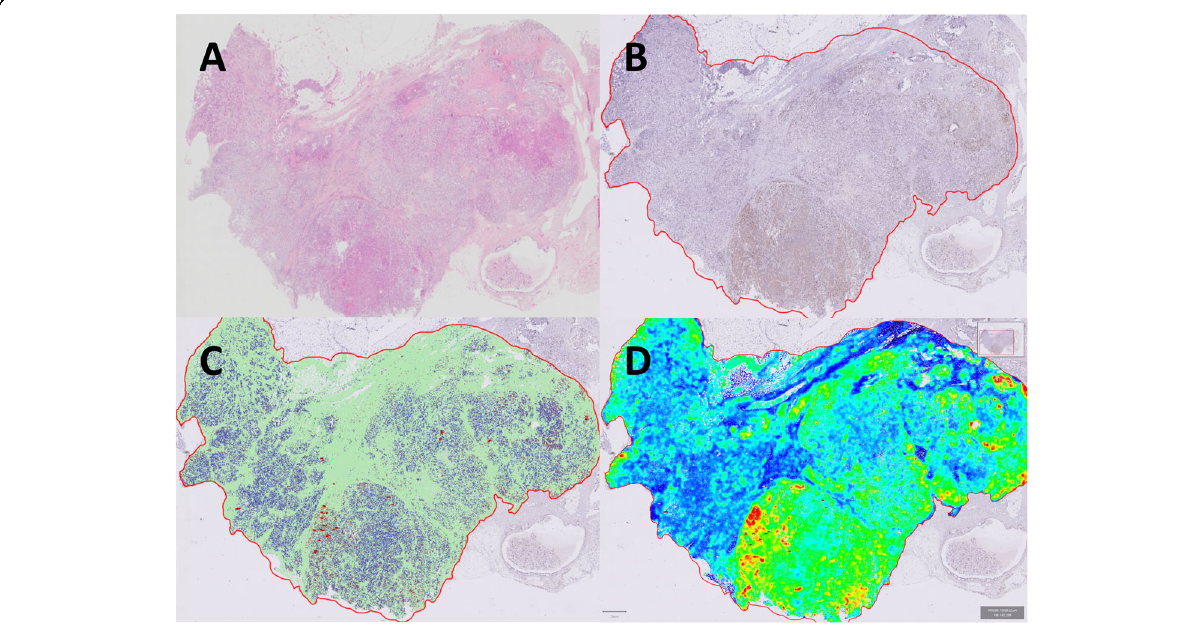
Fig. 3 A HES stained WSI; B IHC stained WSI (Ki-67) with manually delineated tumour area (red); C Cell detection within the tumor area and tumor (blue/red) and non-tumor (green) classified cells; D Measurement heat map showing Ki-67 hot-spots in